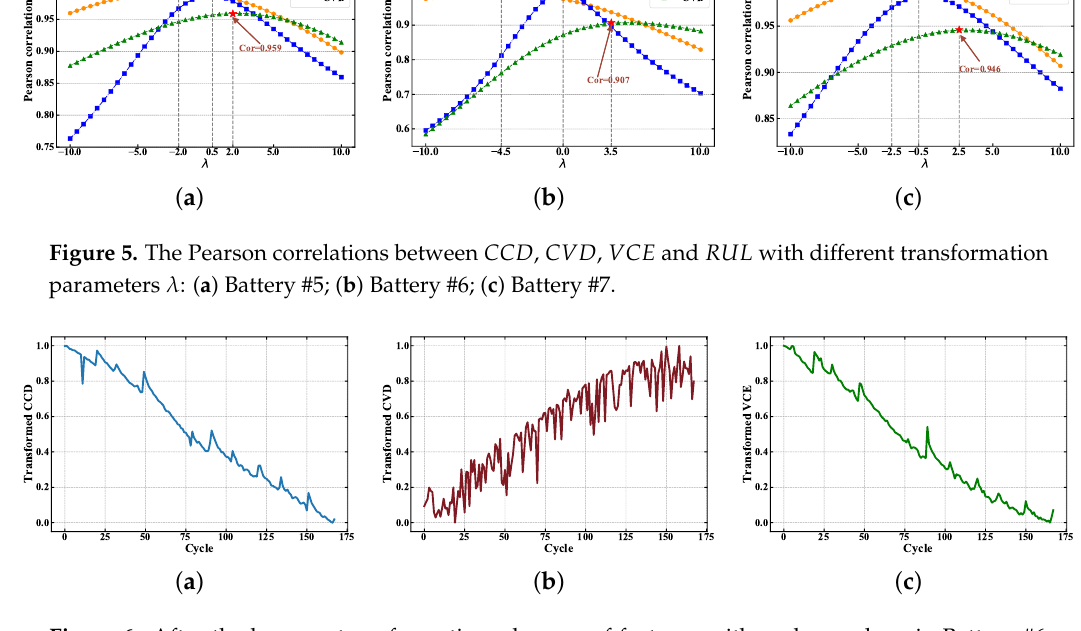
Figure 6. After the box-cox transformation, changes of features with cycle numbers in Battery #6: ( a ) CCD . ( b ) CVD . ( c ) VCE